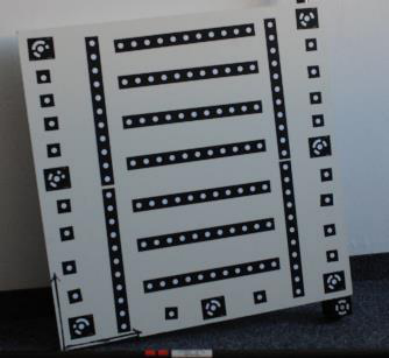
Figure 3. Planar calibration pattern with photogrammetric marks. Coded (w/ annulus) and uncoded marks are used. Marks printed on adhesive paper labels are fixed on a wooden board.